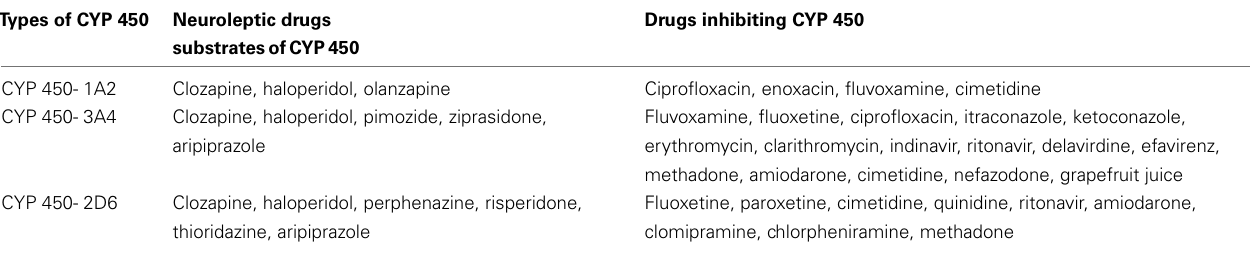
Table 5 | Different types of CYP 450, their substrates, and inhibitors (Prior and Baker, 2003). Types of CYP 450 Neuroleptic drugs